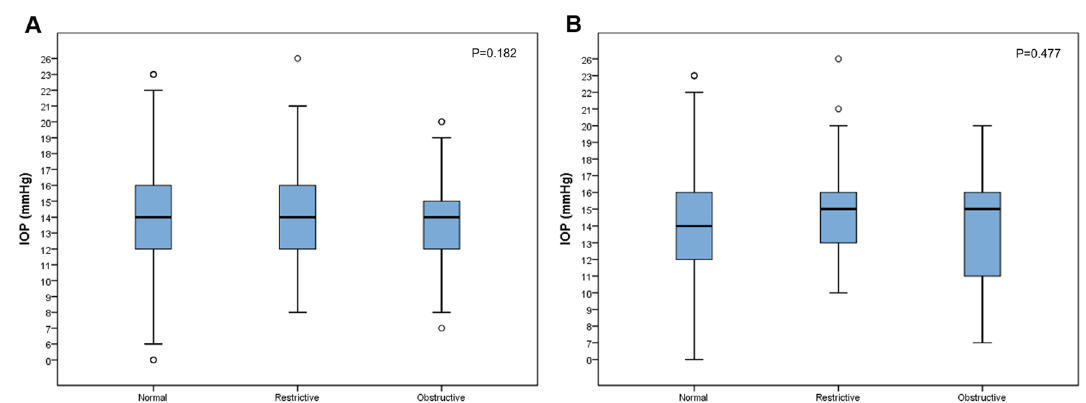
Figure 2. Boxplot for comparison of IOP depending on pulmonary function in women ( A ) and among women with glaucoma ( B ). Comparisons of weighted estimates of average of IOP between the three groups showed that IOP was not different in women of different pulmonary function types ( A , P = 0.182). When women with glaucoma were separately analyzed, no statistically significant difference was noted ( B , P = Association between OAG, smoking status and obstructive pulmonary disease in women. Logistic regression analyses were performed to identify associations between obstructive pulmo- nary disease and OAG (Table 2). Other than COPD, variables included in the analysis were the same parameters that were found to be significant risk factors of OAG from a previous study that employed the same data set of KNHANES 10 . The analyses revealed that COPD was a significant risk factor for OAG in women when age, IOP, refractive status, BMI, HTN, smoking and exercise (OR 2.077, 95% CI 1.137–3.795, P = 0.017) were controlled.